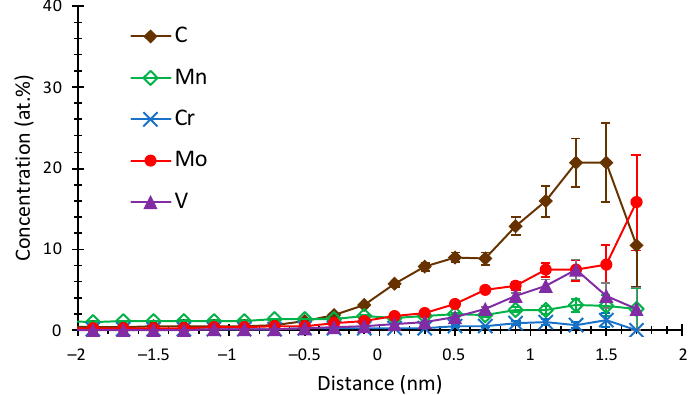
Figure 9. Proxigrams from the small carbides located in the matrix (likely on dislocations) from the sample aged 8 h at 600 °C (see Figure 8).